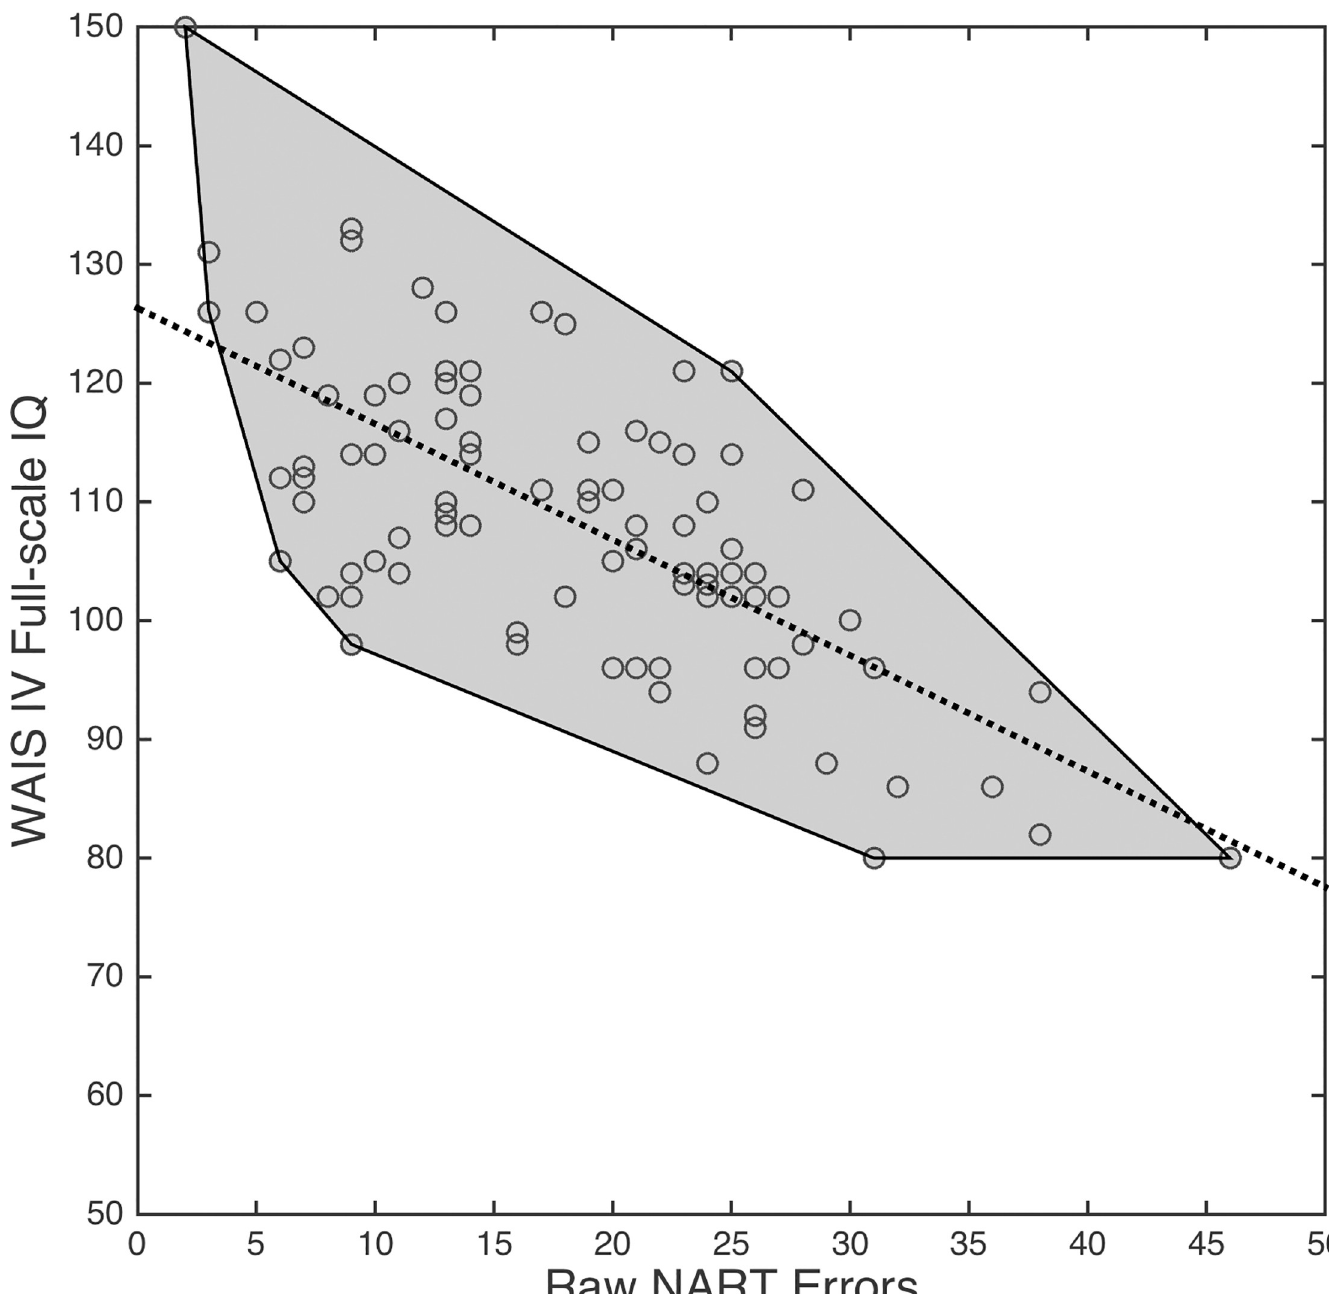
Fig 2. Scatterplot of raw NART errors vs . measured WAIS-IV FSIQ (hollow circles). Dotted black line is initial line equation; shaded zone is the convex hull.